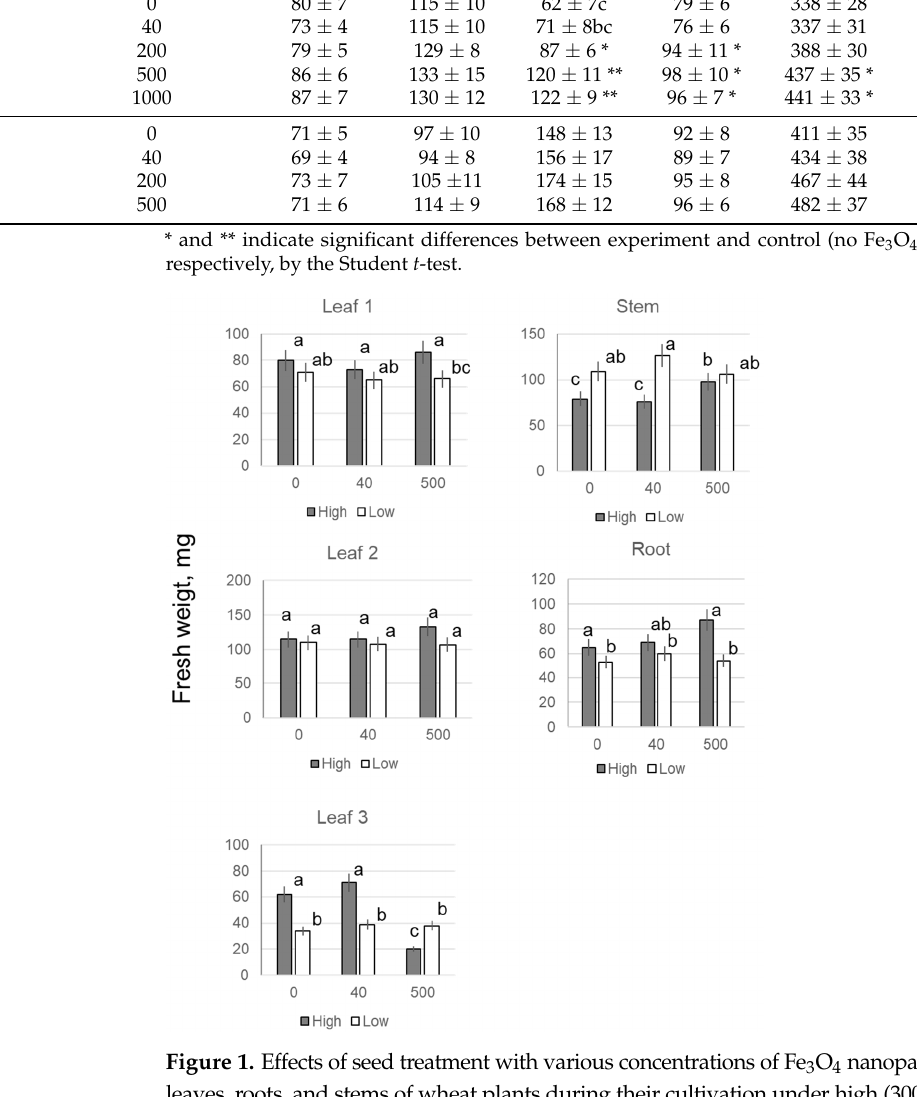
Figure 1. Effects of seed treatment with various concentrations of Fe 3 O 4 nanoparticles on fresh weight of leaves, roots, and stems of wheat plants during their cultivation under high (300) and low light intensity (120 µ mol (photons) m − 2 · s − 1 ). Data are means ± SD ( n = 5). Data labelled with different low-case letters are significantly different at p <